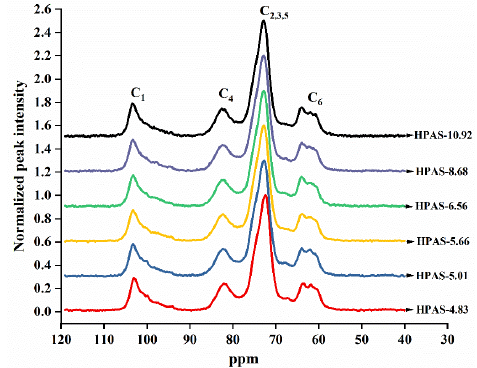
Figure 9. 13 C solid-state nuclear magnetic resonance (SSNMR) spectrum of HPAS-CA films with different citric acid amount.